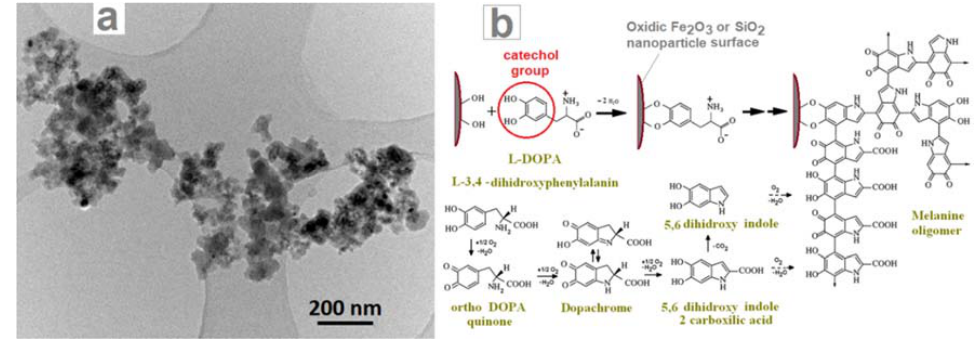
Figure 5. ( a ) TEM image of L -DOPA coated aggregates of nanoparticle derived from Fe-Si3 sample; ( b ) Proposed mechanism for L -DOPA attachment and polymerization to oligomelanin on the nanoparticles oxidic surface.